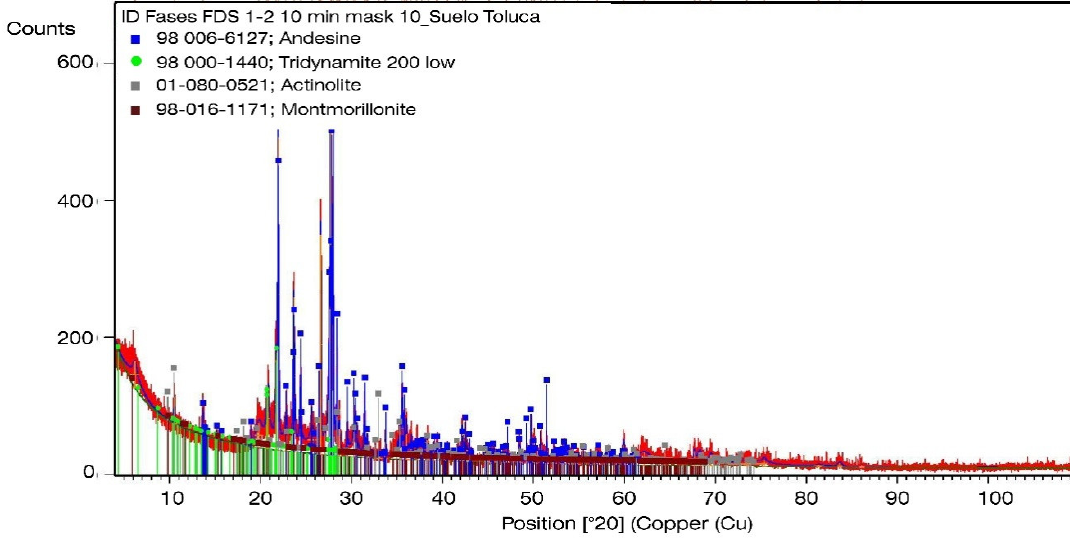
Figure 6. Diffractogram of the excavation material mixture.